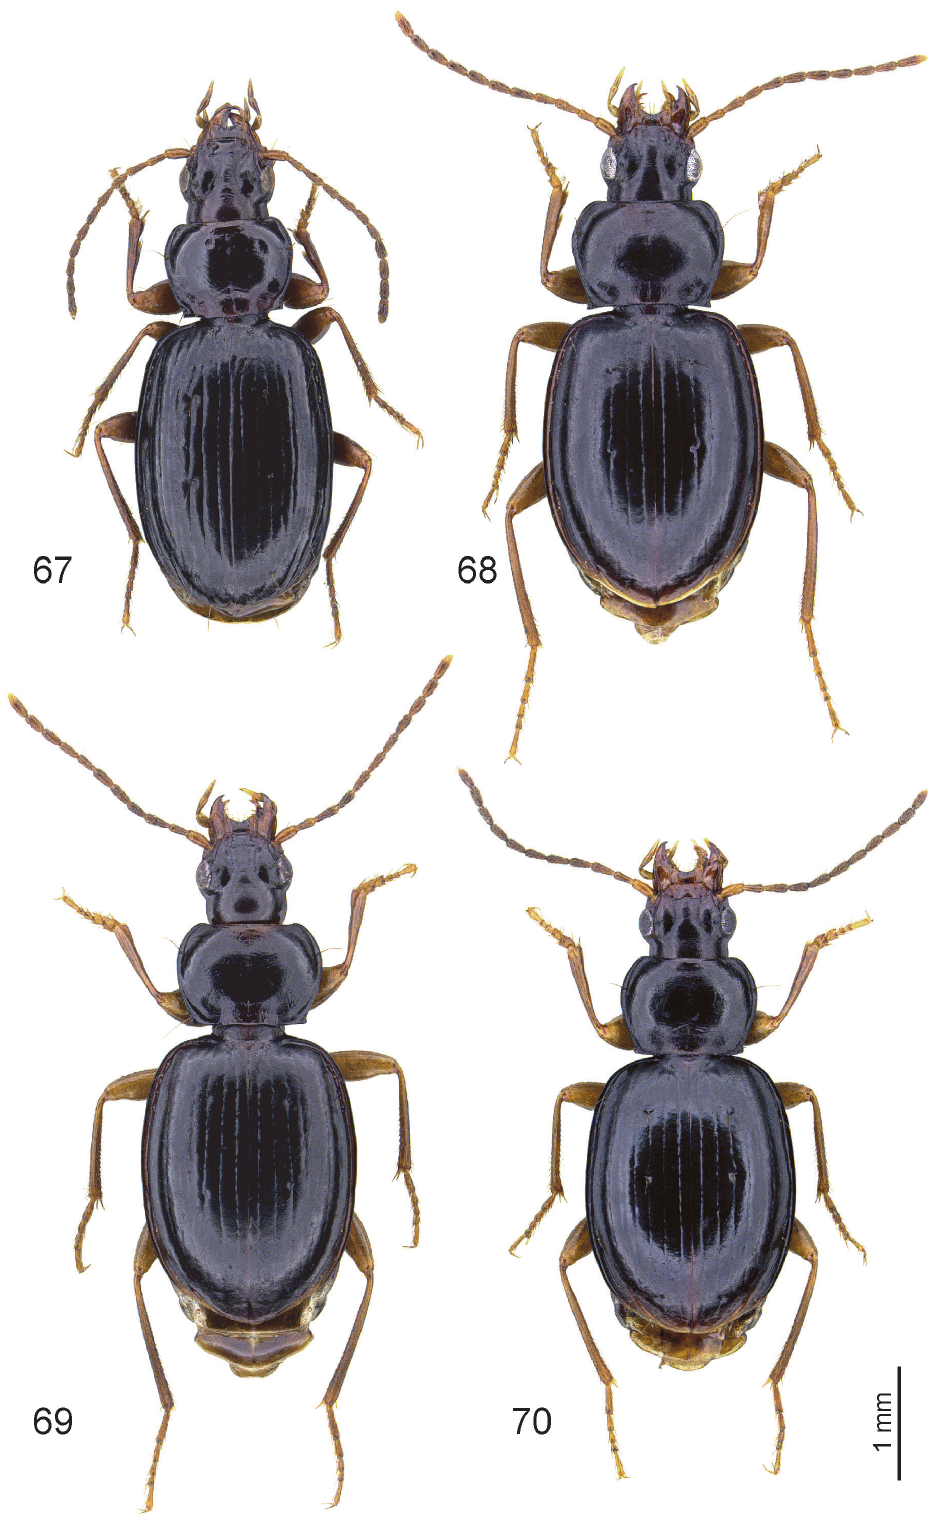
Figs 67–70. Trechus spp., habitus. 67 . T. depressipennis sp. nov., holotype. 68 . T. mekbibi sp. nov., paratype, ♂. 69 . T. hagenia sp. nov., paratype, ♂. 70 . T. colobus sp. nov., paratype,